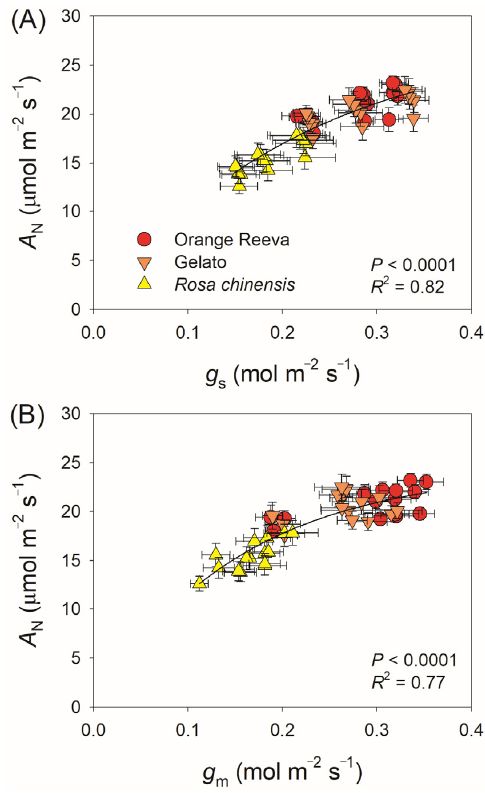
Figure 5. Relationships between stomatal conductance ( g s ) and leaf net CO 2 assimilation rate ( A N ) ( A ) and between mesophyll conductance ( g m ) and A N ( B ) during high light phase in fluctuating light. Data are means ± SE ( n = 5).